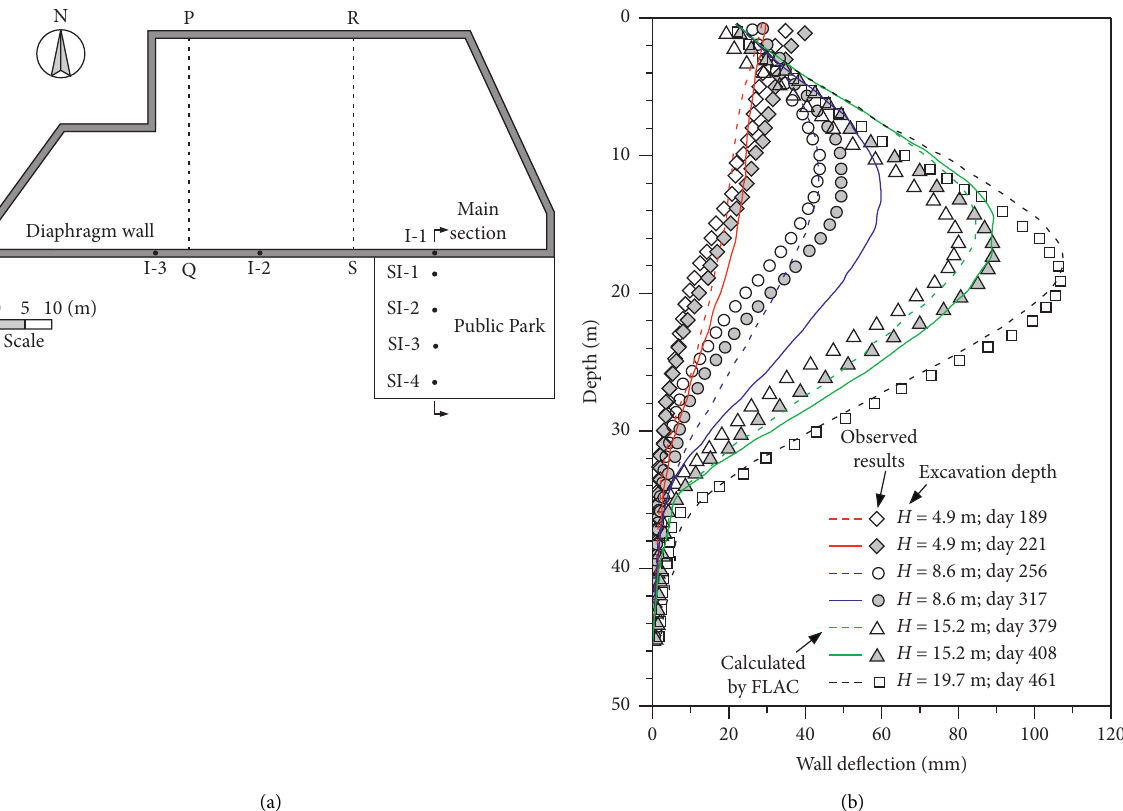
Figure 1: The TNEC excavation project: (a) instrumentation layout; (b) comparison of observed and calculated lateral wall deflections at typical excavation depths, modified from